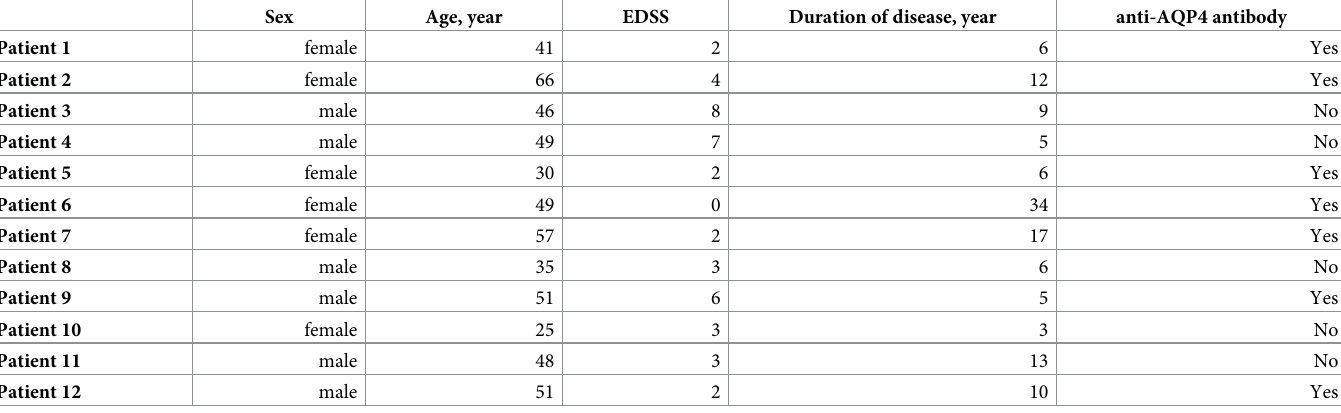
Table 1. Demographic, clinical and biological data of the patients